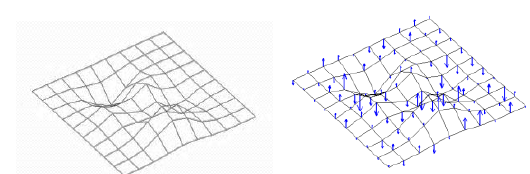
Figure 3. A surface (left) and the gradient of its vertices (right) visualized by the